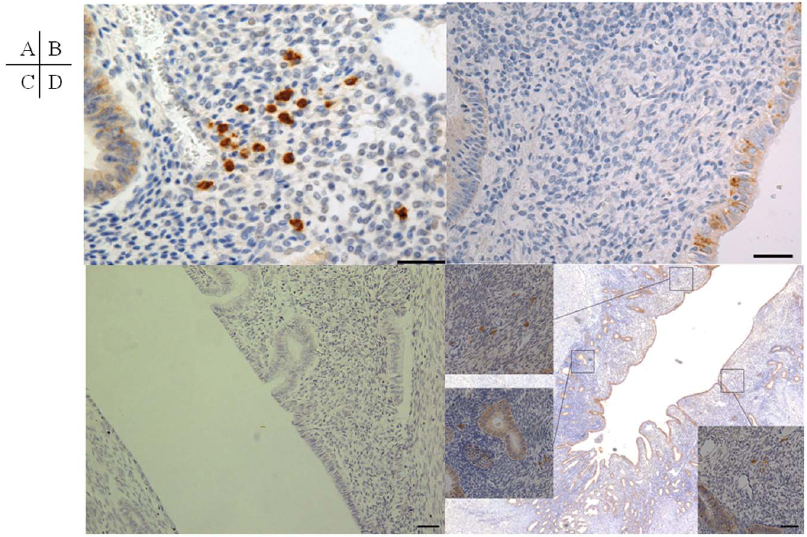
Figure 1. Immunohistochemistry for CD138. (A) Plasma cells immunostained by CD138 are detected in the stromal compartment of chronic endometritis. (B) Plasma cells are not detected in the stromal compartment of non-chronic endometritis, although CD138 is also immunostained in the epithelium of all sections. (C) No immunostaining is detected in the negative control in which anti-CD138 antibody has been omitted. (D) Plasma cells can be found in at least three of ten non-overlapped random fields once a plasma cell is detected in a stromal compartment. Since chronic endometritis does not localize focally but expands to involve the entire endometrial stroma, a number of plasma cells is detected in random endometrial stromal compartments in chronic endometritis. Bar=100 m m.